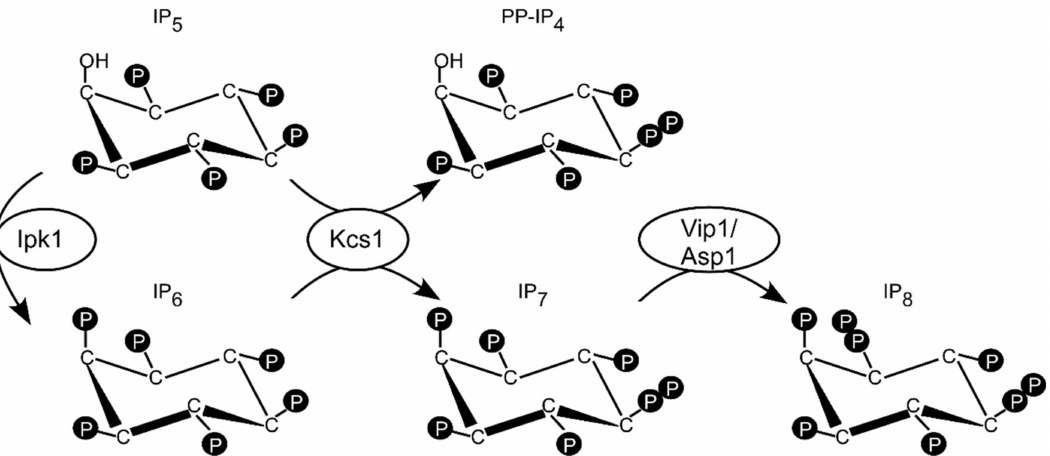
Figure 1. Schematic representation of the inositol pyrophosphates metabolic pathway in S. pombe and S. cerevisiae . Inositol hexakisphosphate IP 6 synthesized by Ipk1 is further phosphorylated to IP 7 by the Kcs1 enzyme, that is also metabolizing IP 5 to PP-IP 4 . IP 8 is synthesized by Asp1 ( S. pombe ) or Vip1 ( S. cerevisiae